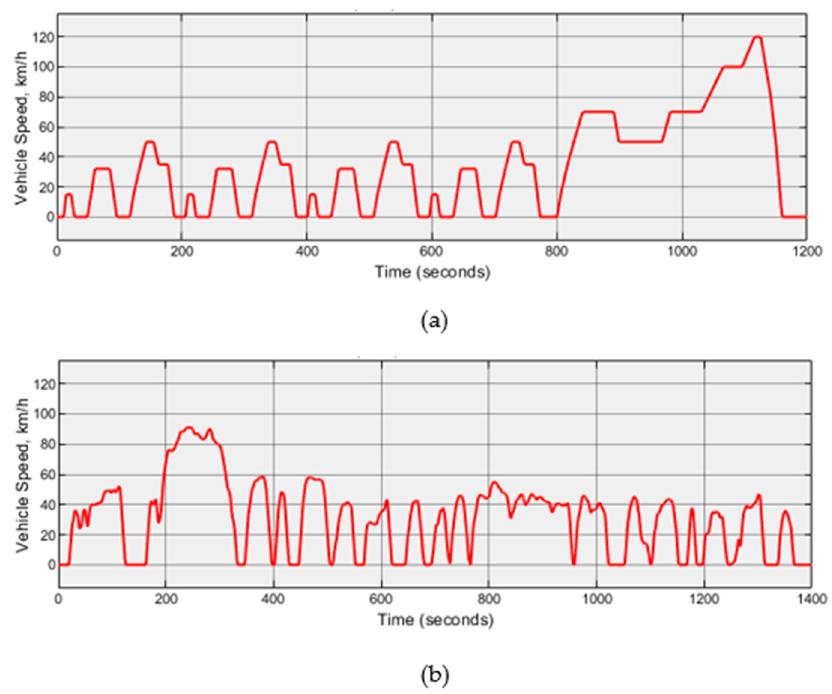
Figure 9. Vehicle driving conditions: ( a ) NEDC—New European Drive Cycle and ( b ) UDDS—Urban Dynamometer Driving Schedule.